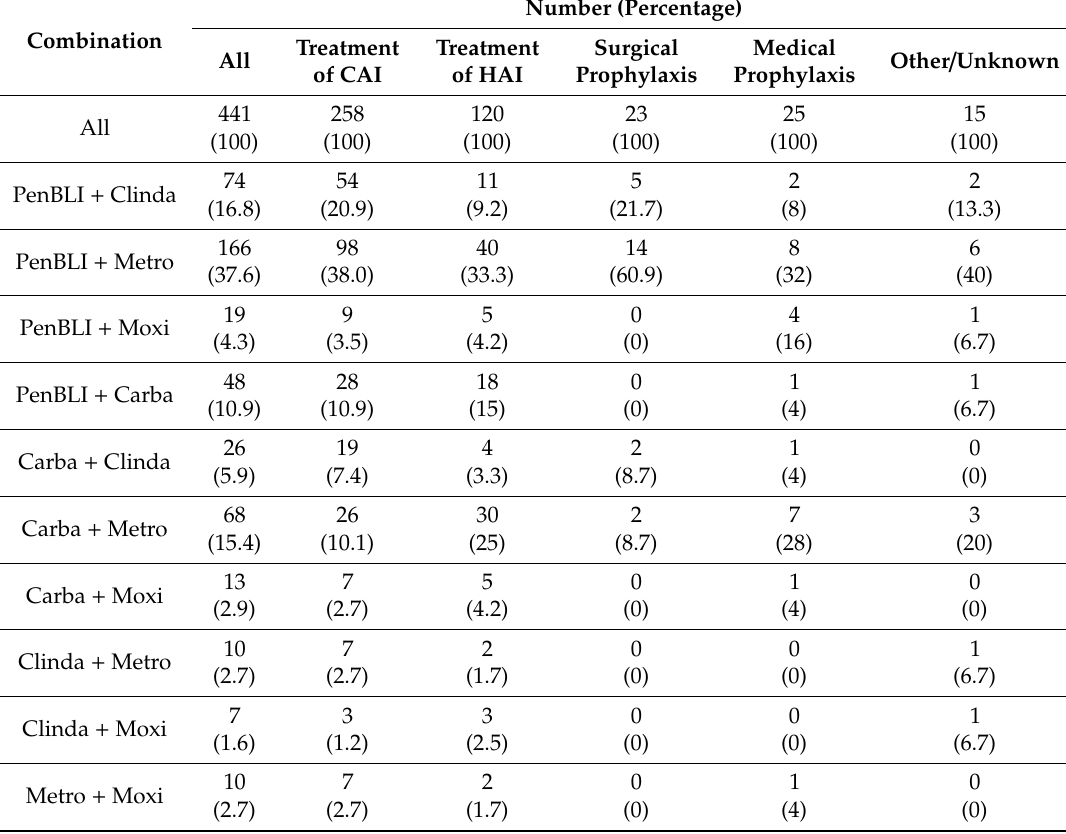
Table 4. Indications of redundant anaerobic antimicrobial prescriptions stratified by the combination of anaerobic antimicrobial agents. Data from 218 hospitals that participated in the point prevalence survey